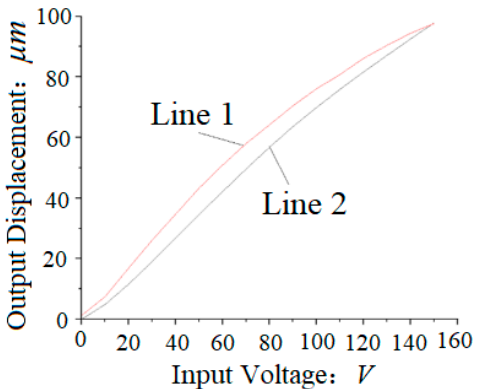
Figure 3. The open-loop voltage and displacement curve of piezoelectric ceramics. Line 1: Relation- ship between rising input voltage and measured output displacement; Line 2: Relationship between down input voltage and measured output displacement.